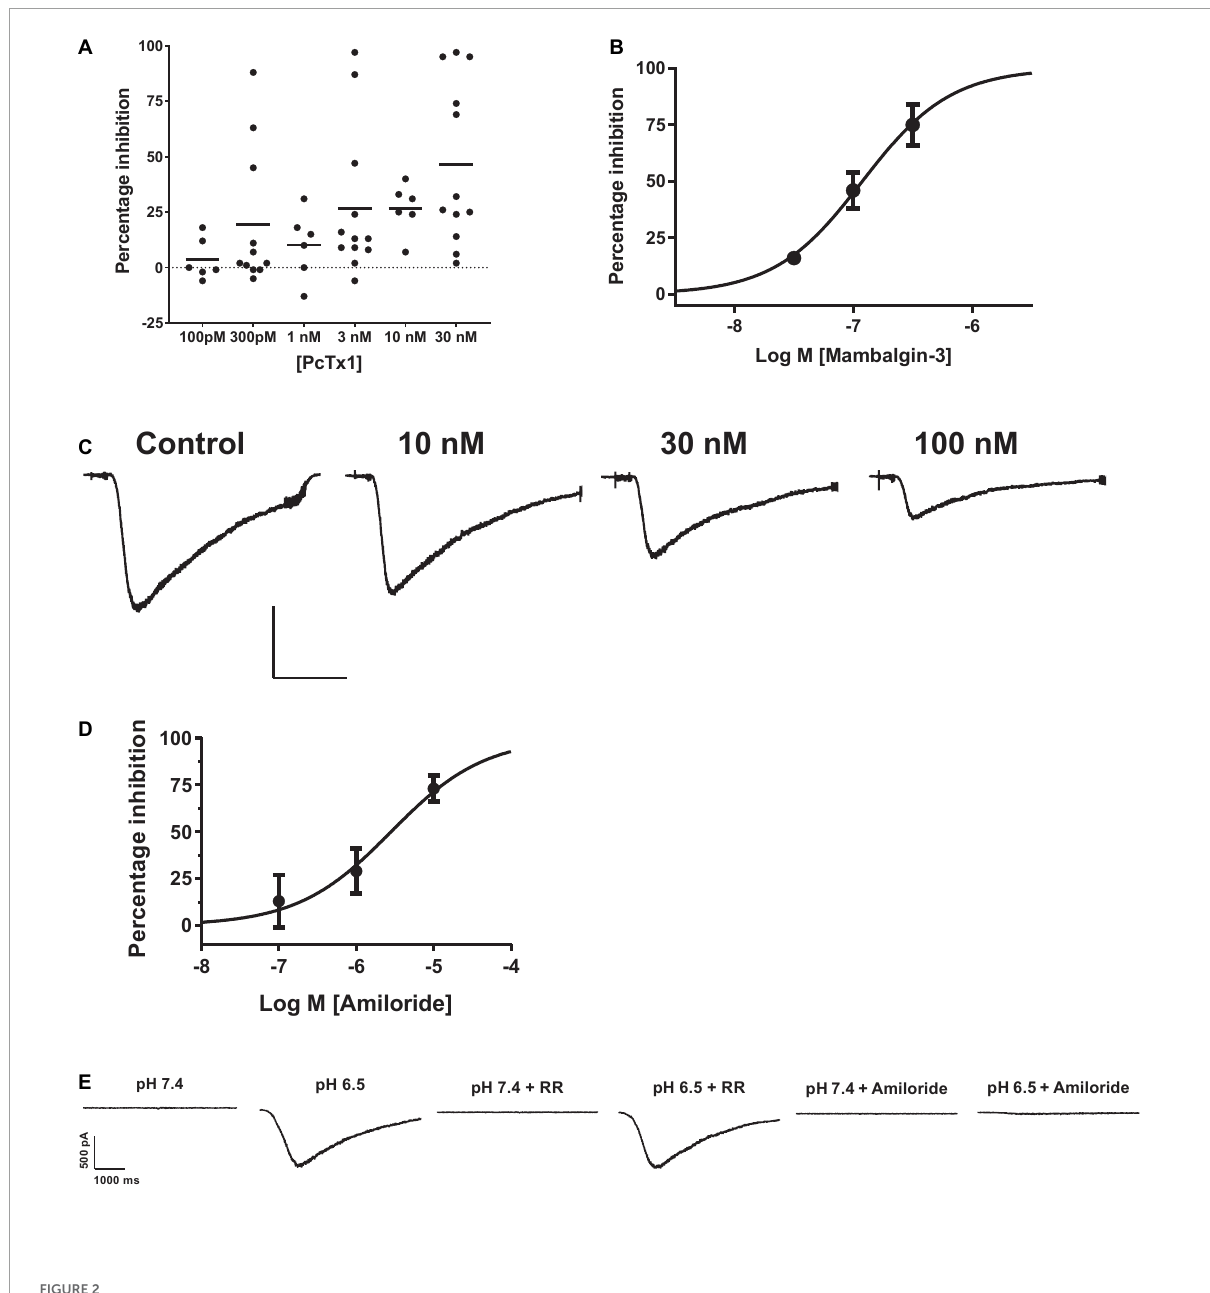
FIGURE2 Pharmacology of endogenous proton-activated currents in HEK cells. (A) Individual % inhibition values plotted against concentration of PcTx1 applied during QPatch 48 recordings, with mean shown by horizontal black lines. Data was obtained from cumulative IC 50 assays where each cell was exposed to three concentrations of PcTx1, typically in half log unit increments. (B) Potency of Mambalgin-3 to inhibit pH-activated currents plotted as a cumulative concentration-response IC 50 curve. Symbols are mean ± S.D ( n = 2 or 3). (C) Exemplar current traces from a HEK cell in response to pH 6.5 activation before and after pre-incubation in increasing concentrations of Mambalgin-3. Scale bar is 500 pA and 1 s. (D) Inhibition of proton-activated currents in HEK cells by Amiloride. Data was obtained in a similar fashion to C, with each cell stimulated by pH 6.5 solution and then pre-incubated in increasing concentrations of Amiloride to construct a cumulative mini-IC 50 curve. Symbols are mean ± S.D ( n = 3). (E) Endogenous proton-activated currents are insensitive to Ruthenium Red (RR, 1 µ M) but completely inhibited by a non-selective concentration of the ASIC/ENaC/Degenerin antagonist Amiloride (100 µ M). The HEK cell was stimulated by pH 6.5 solution and then pre-incubated (at pH 7.4) in RR or Amiloride followed by consecutive stimulation with pH 6.5 solution containing RR or